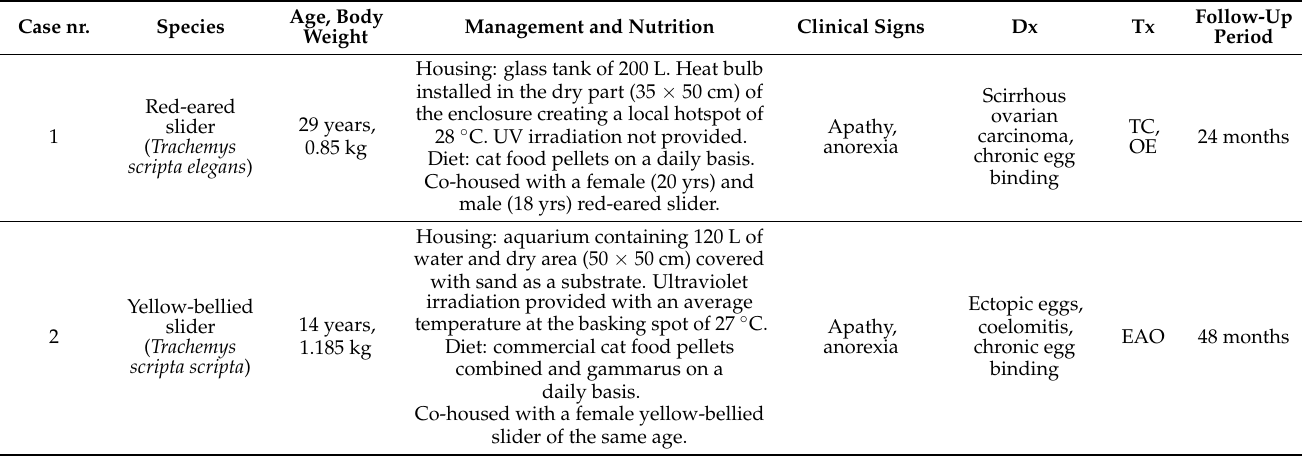
Table 1. Overview of chelonian cases with reproductive disorders that were treated with